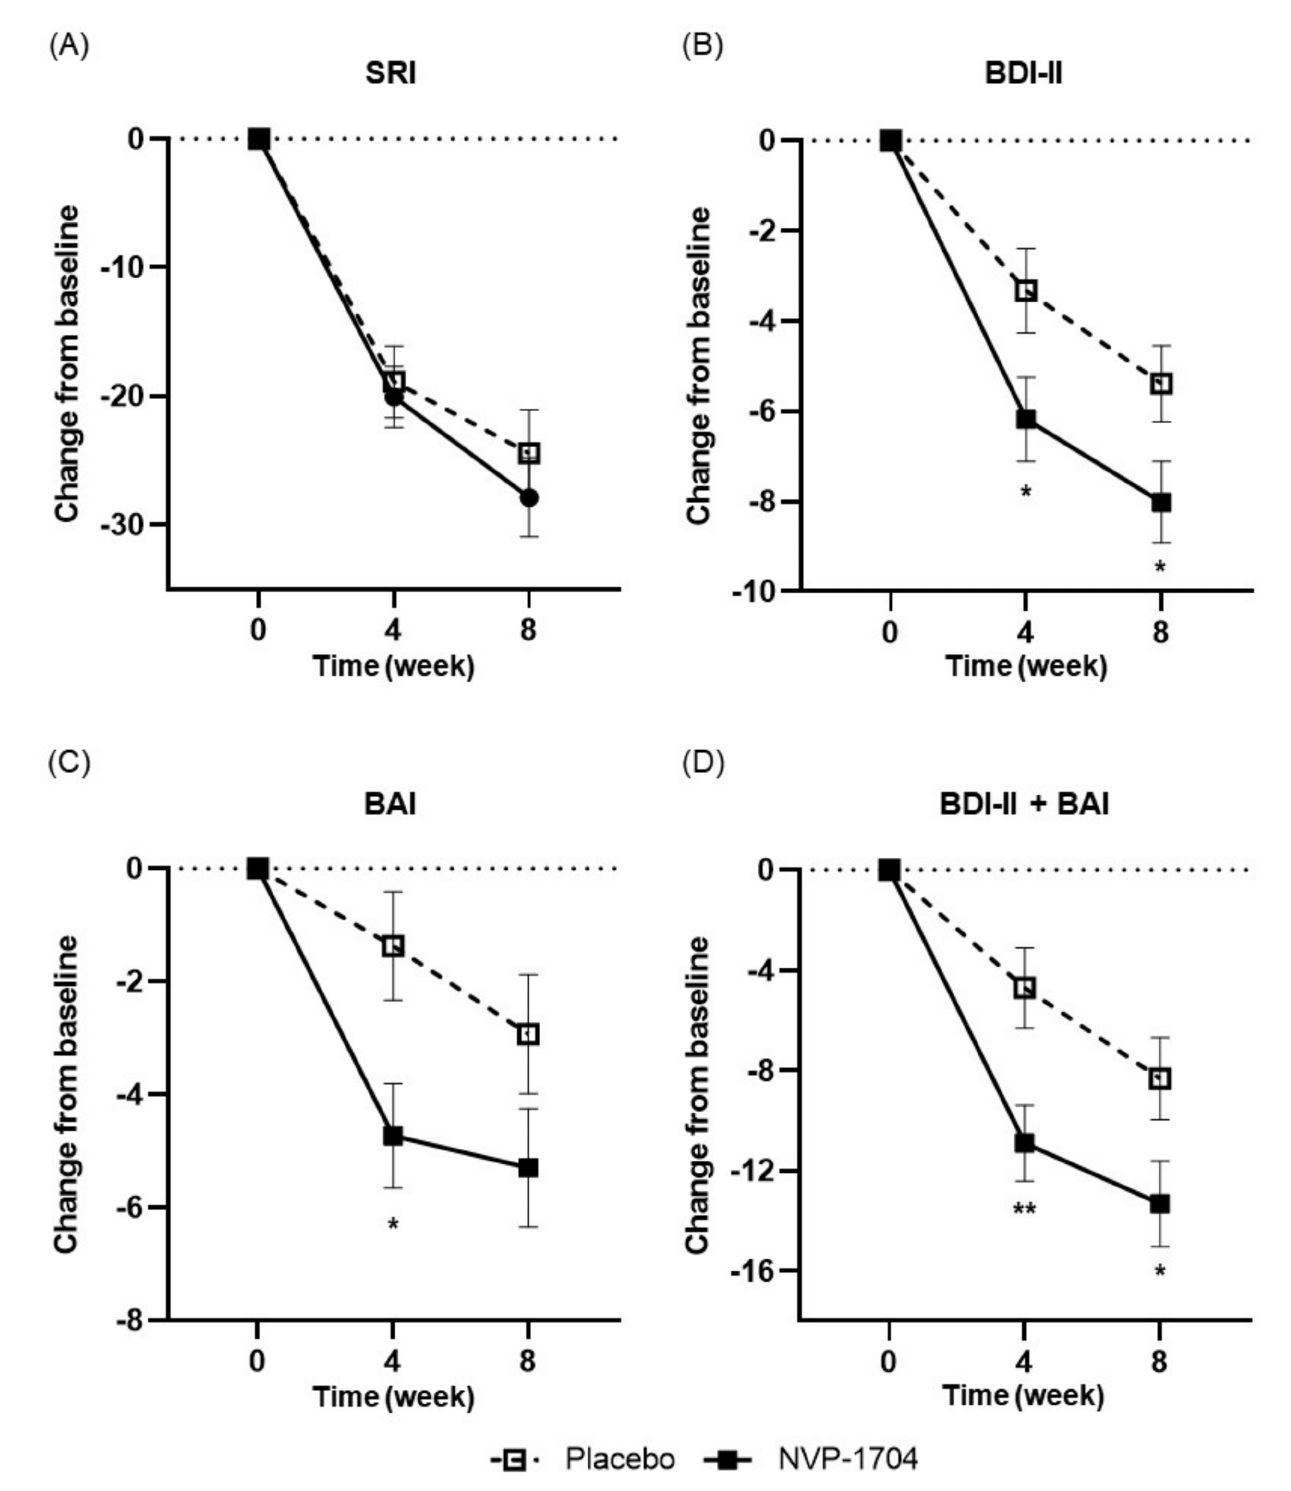
Figure 3. Effects of NVP-1704 on mood parameters such as SRI score ( A ), BDI-II score ( B ), BAI score ( C ), and the sum of BDI-II and BAI scores ( D ). Scores are shown as 4- and 8-week mean changes from baseline during the study period. Independent t -tests were performed. Data values are described as the mean ± standard error of the mean. Asterisks indicates a statistically significant difference between the two groups (* p < 0.05, ** p < 0.01). SRI, Stress Response Inventory; BDI-II, Beck’s Depression Inventory; BAI, Beck’s Anxiety